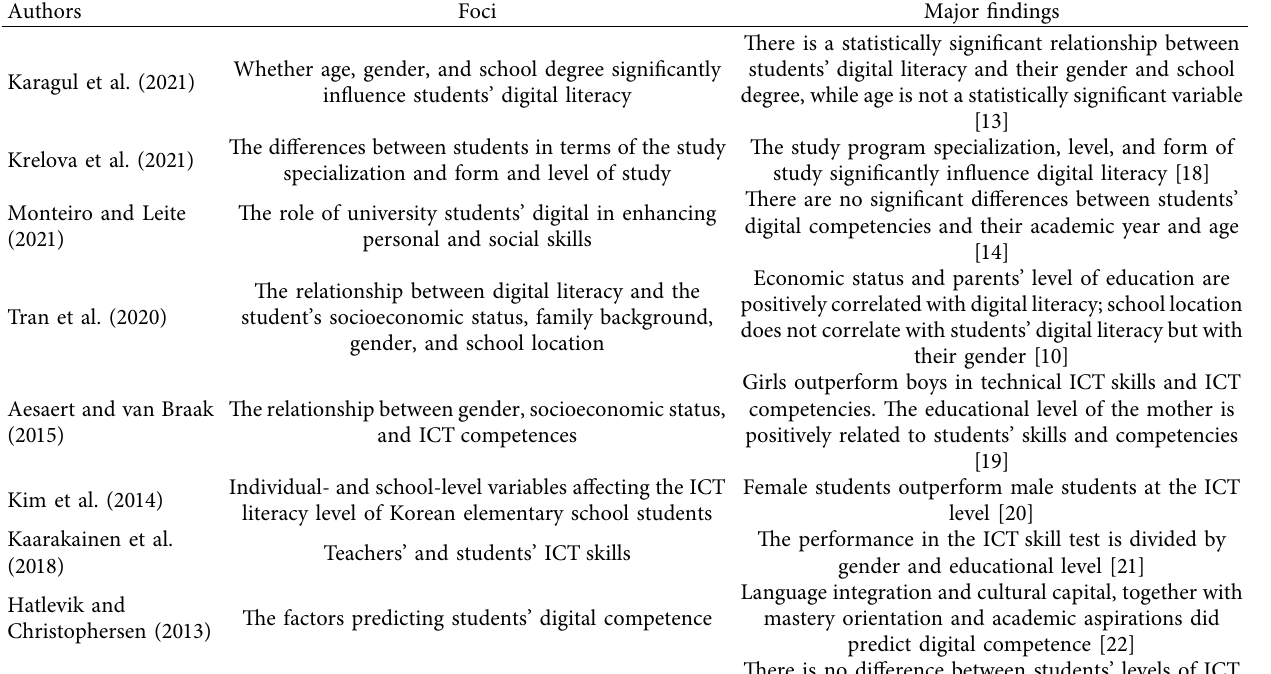
Table 1: Authors, foci, and major findings of the included literature guiding this